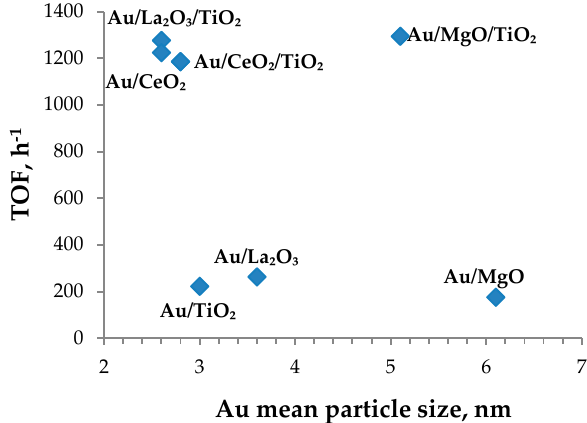
Figure 3. Turnover frequency (TOF) in glycerol oxidation for gold supported catalysts as a function of gold mean particle size. Table 5. Basic properties of the catalysts and corresponding supports, TOF values and mean particle size (D mean ) of the catalysts. Adapted from [37,38], except the data for MgO-based catalysts (entries 6 and 7), which is presented for the first time in this